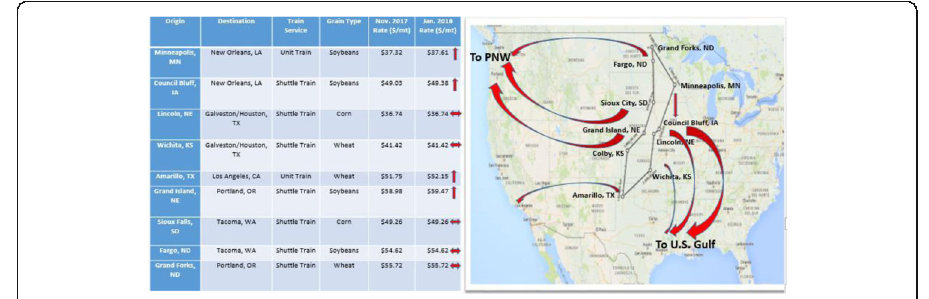
Fig. 3 Shuttle and Unit Trains Grain Shipments and “ Contest Area ” U.S. Gulf vs PNW. Source: USDA-GTR (Table 4). Drawing by author using USDA- GTR data and google